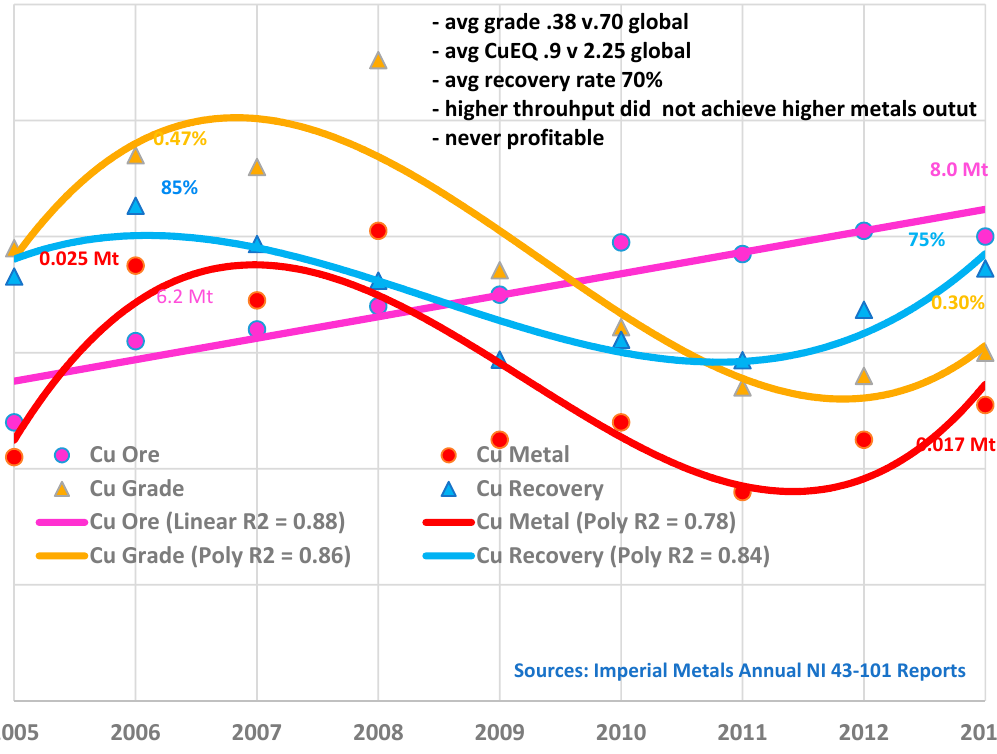
Figure 6. Mt Polley economics pre-failure.